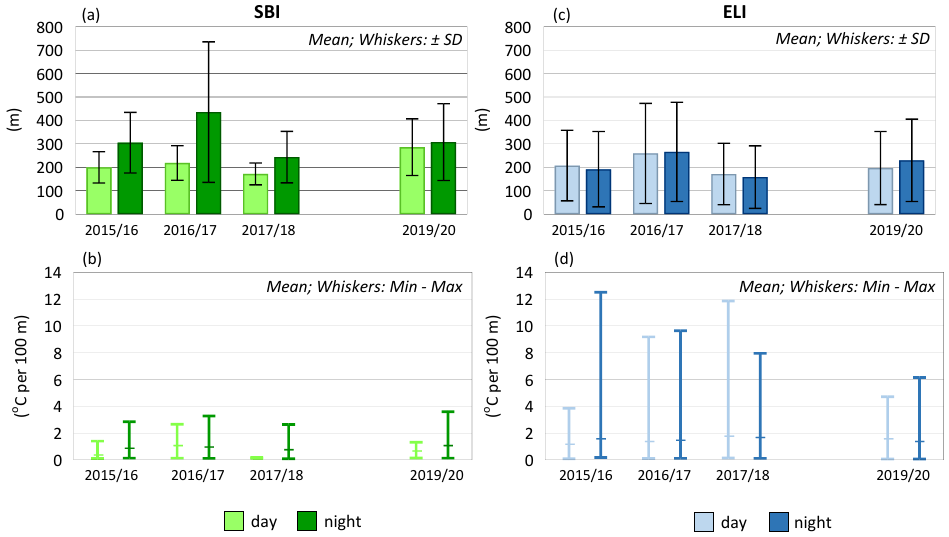
Figure 3. Thickness and strength of the SBI ( a , b ) and ELI ( c , d ) inversion layers. SD—standard